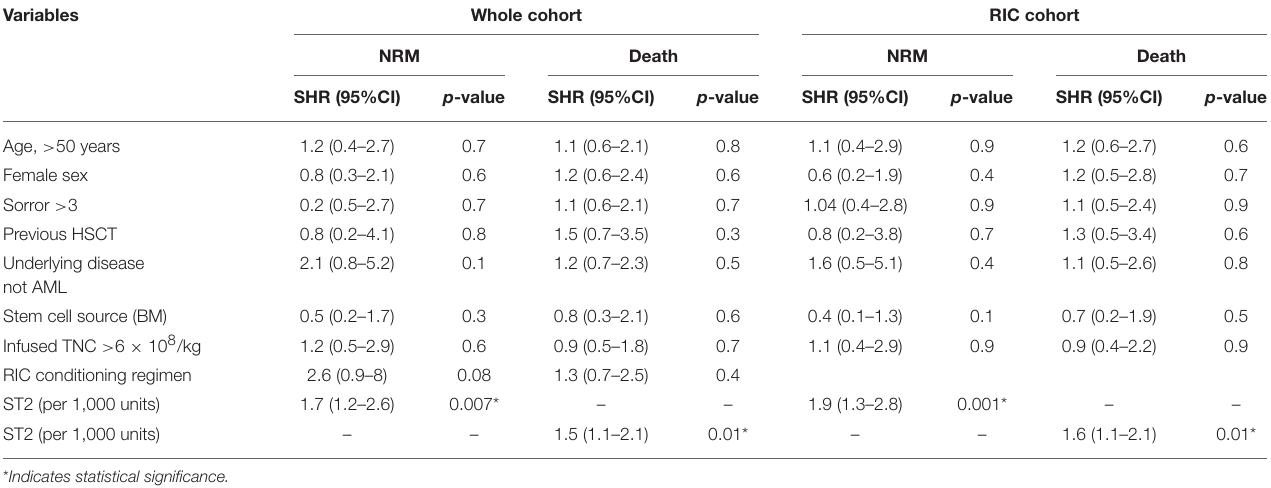
TABLE 6 | Univariable associations between ST2 levels at day + 30 and clinical variables with NRM and death in the whole and RIC cohorts using the Fine-Gray model. Variables